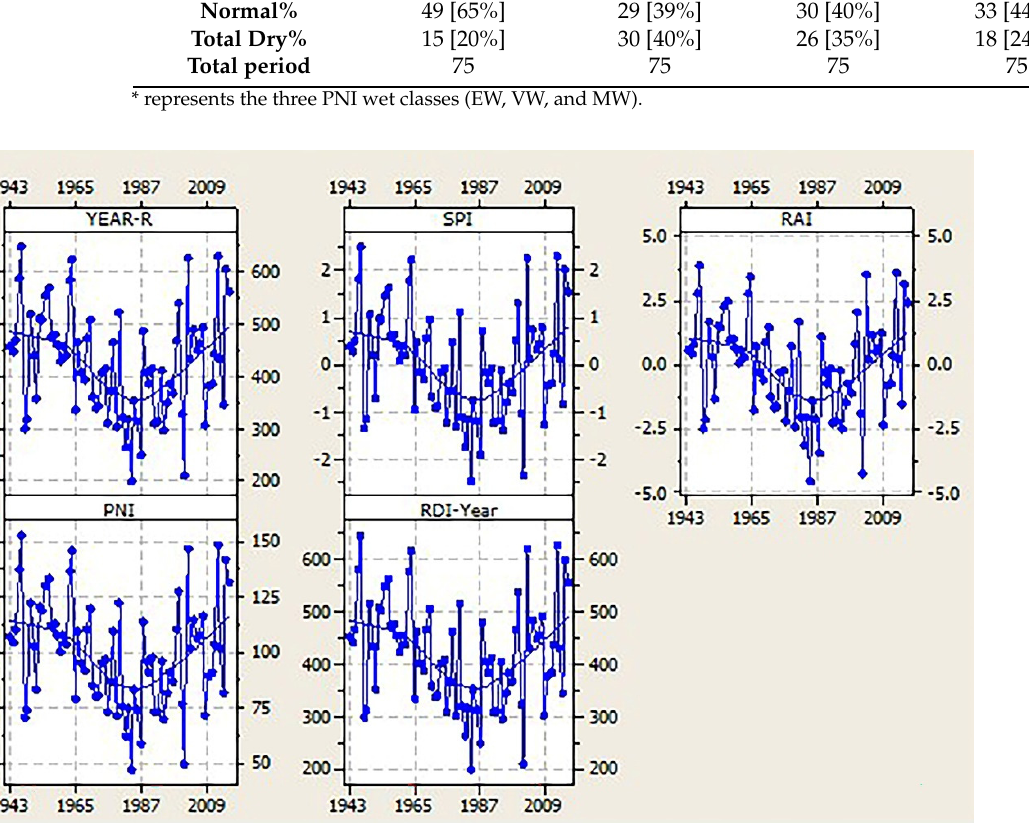
Table 4. Seasonal (monthly and annual) drought frequencies for SPI, RDI, RAI, and PNI.